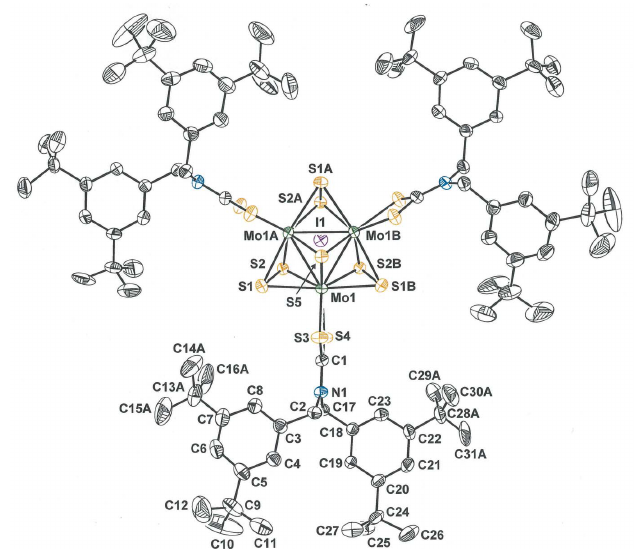
Figure 1 Displacement ellipsoid plot of [Mo 3 S 7 (S 2 CN(CH 2 C 6 H 3 -3,5- t Bu 2 ) 2 ) 3 ]I at the 50% probability level with view along the threefold symmetry axis. All hydrogen atoms are omitted for clarity. tert -Butyl groups C13–C16 and C28–C31 are edited to show one of two positional variants in a split- atom model for the disorder. Symmetry codes: A = 1 (cid:2) y , 1 + x (cid:2) y , z ; B = (cid:2) x + y , 1 (cid:2) x , z